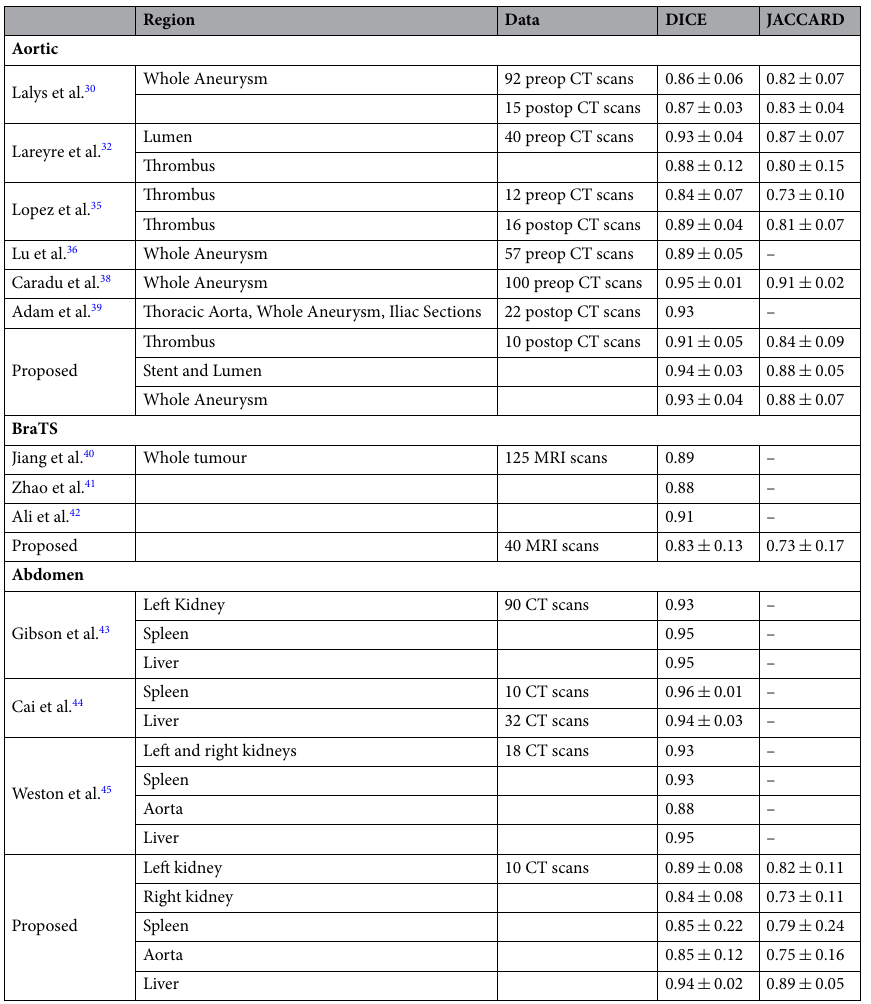
Table 7. Recently published segmentation experiments on cross-sectional images of solid organs or